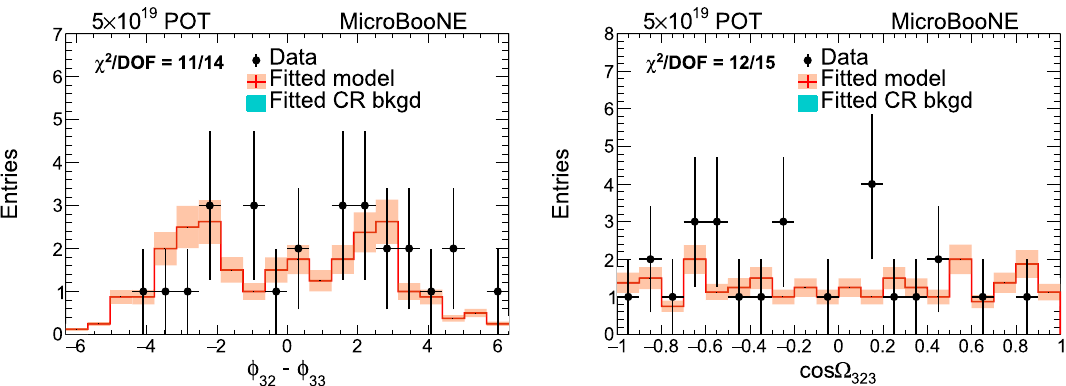
Fig. 27 Multiplicity = 3 φ 2 − φ 3 distribution (left); cos (cid:18) 23 distribution between second and third track (right) from neutrino-enriched sample for data and GENIE default